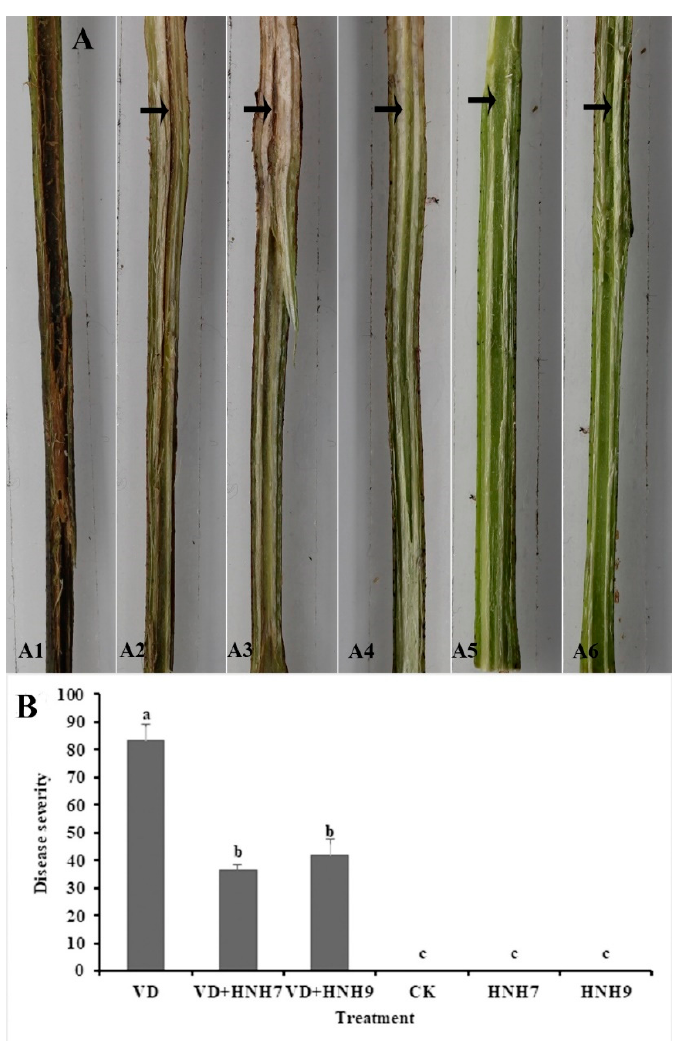
Figure 8. Greenhouse evaluation of disease incidence reduction by endophytic bacterial strains in cotton plants. A1 = VD-080 only, A1 = HNH7 + VD-080, A3 = HNH9 + VD-080, A4 = Ck (water only), A5 = HNH7 and A6 = HNH9. ( A ) = Infection progress in cotton stem, ( B ) = disease severity. → indicates the infected part of the plant. The disease severity index and biocontrol efficacy were recorded on a 0–4 scale, where 0 = no symptoms or no vascular browning; 1 = 1–25% vascular browning; 2 = 26–50% vascular browning; 3 = 51–75% vascular browning; 4 = more than 75%.The mean values were computed and LSD test at p ≤ 0.05 after one-way ANOVA was conducted. The error bars indicate the standard error ± SE of the mean values. Corresponding results of ANOVA, F = 97.9, p = 0.000. Letters (a-c) above the columns represent significant differences between treatment means at p ≤ 0.05.